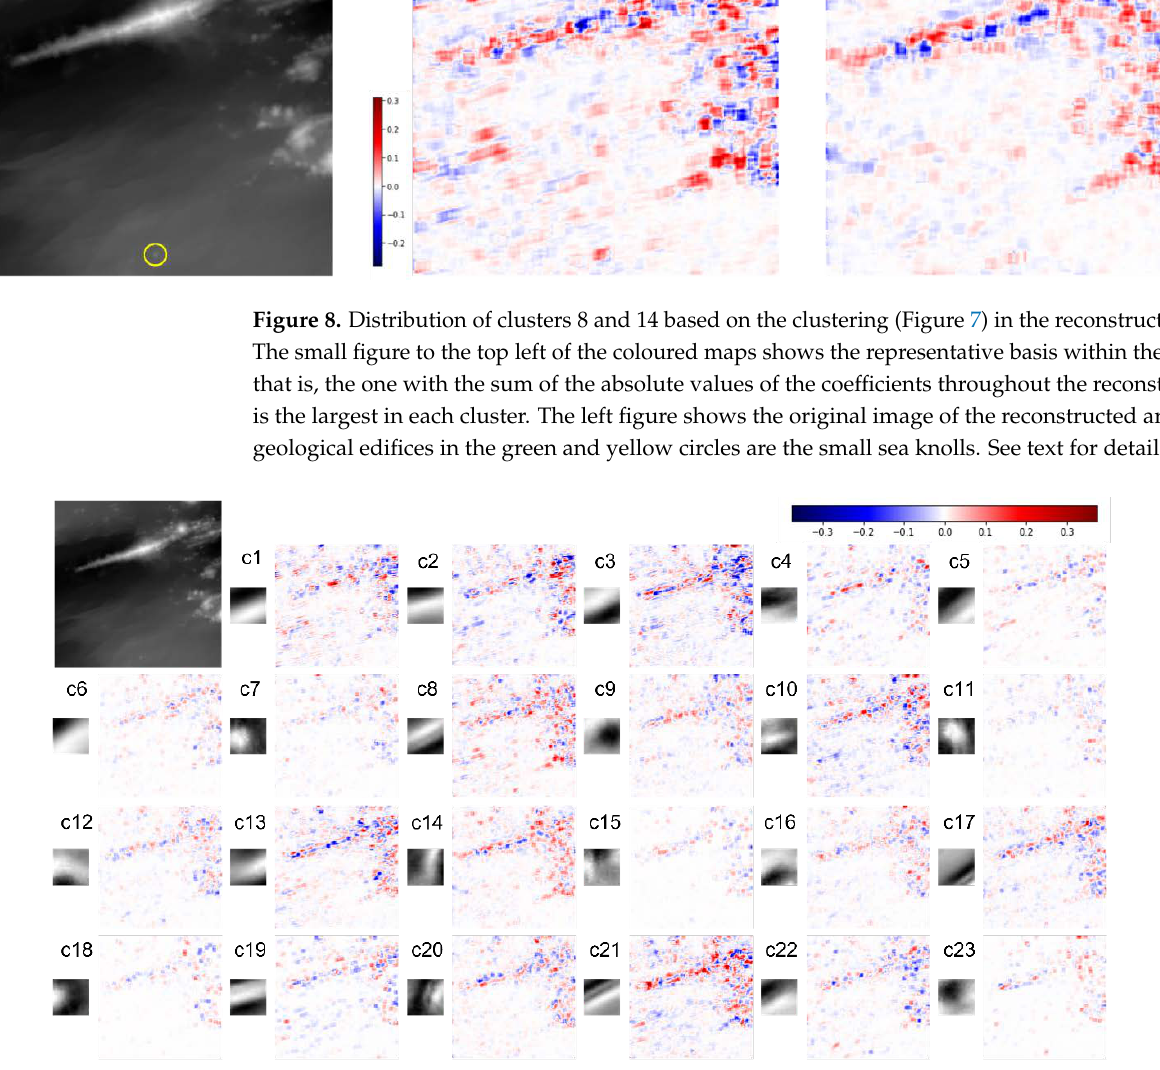
Figure 9. Distribution of the 23 clusters in the reconstructed area. The small figure to the left of each map shows the representative basis of the cluster. The scale of the colour bar is identical to that shown in Figure 8.